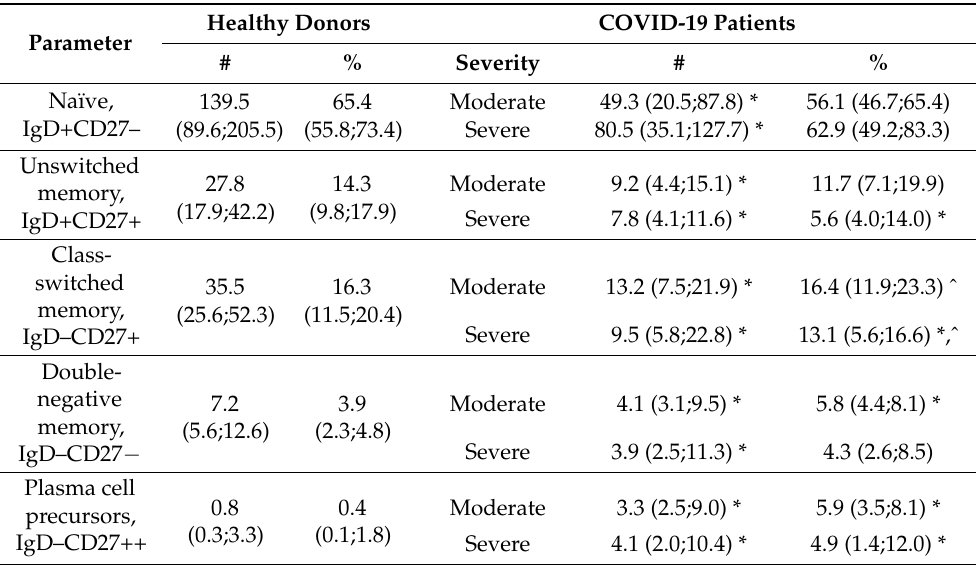
Table 4. Absolute and relative numbers of B-cell subsets identified using IgD − vs. − CD27 classifica- tion in patients with COVID-19 and in healthy